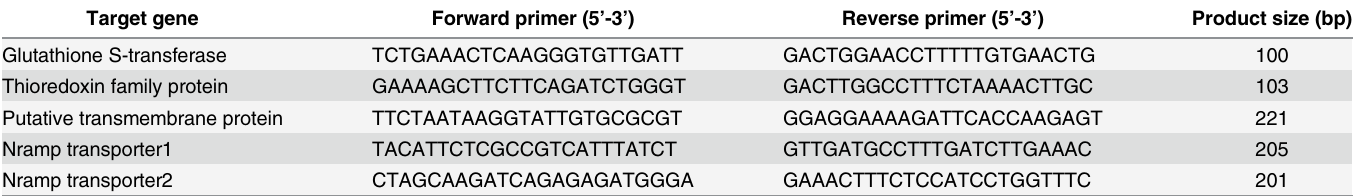
Table 2. Primer used for real-time quantitative RT-qPCR